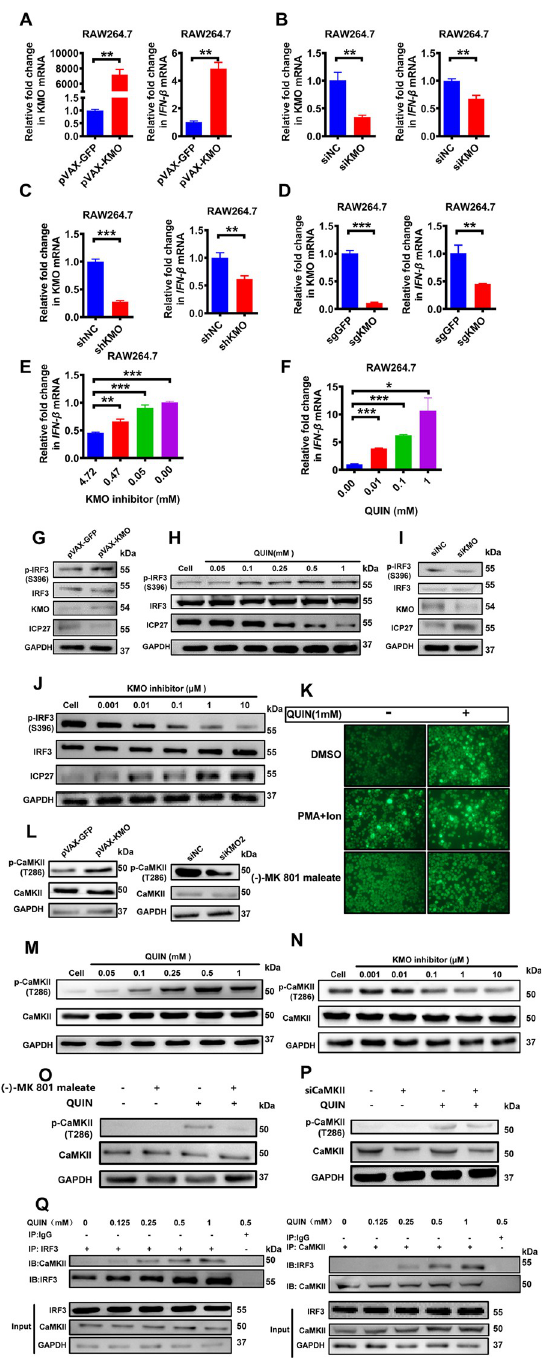
Fig 3. The antiviral mechanisms of KMO and QUIN by activating IRF3 phosphorylation-mediated IFN- β production. (A) RAW264.7 cells were transfected with plasmids (1 μ g/mL) expressing GFP, KMO for 24 h, followed by HSV-1 infection at MOI of 0.25 for 8 h, and then the expression of KMO and IFN- β were measured by RT-qPCR. (B) RAW264.7 cells were transfected with siRNA for 24 h, followed by HSV-1 infection at MOI of 0.25 for 8 h, and the expression of KMO and IFN- β were measured by RT-qPCR. (C) RAW264.7 cells were infected with shRNA- expressing lentivirus for 24 h, followed by HSV-1 infection at MOI of 0.25 for 8 h, and the expression of KMO and IFN- β were measured by RT-qPCR. (D) RAW264.7 cells were infected with sgRNA-expressing lentivirus for 24 h, followed by HSV-1 infection at MOI of 0.25 for 8 h, and the expression of KMO and IFN- β were measured by RT- qPCR. (E) RAW264.7 cells were pretreated with the indicated concentration of KMO inhibitor for 8 h, followed by